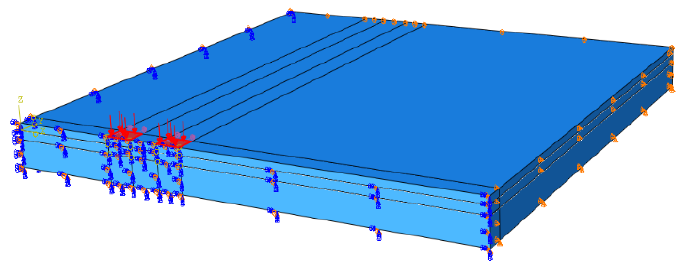
Figure 3. Boundary conditions of 1/4 three-dimensional FE model.